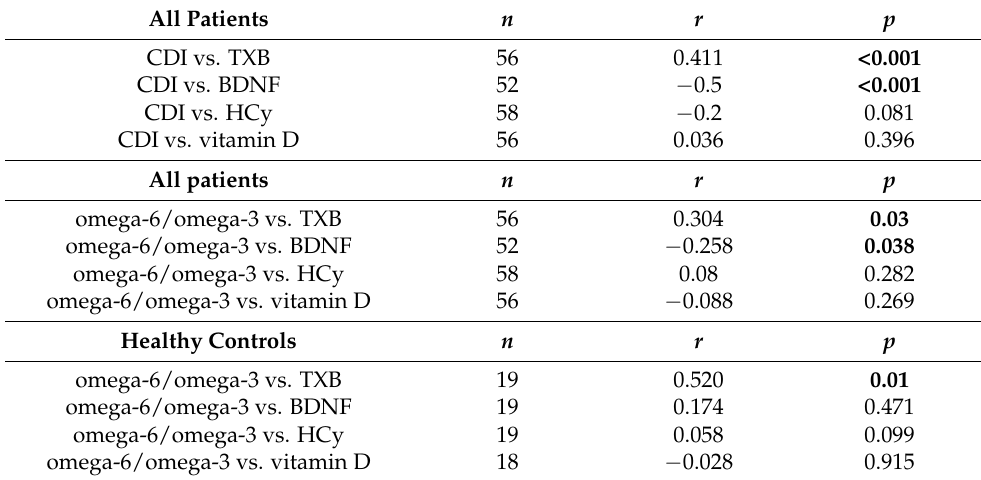
Table 4. Correlations between parameters in patients and controls at